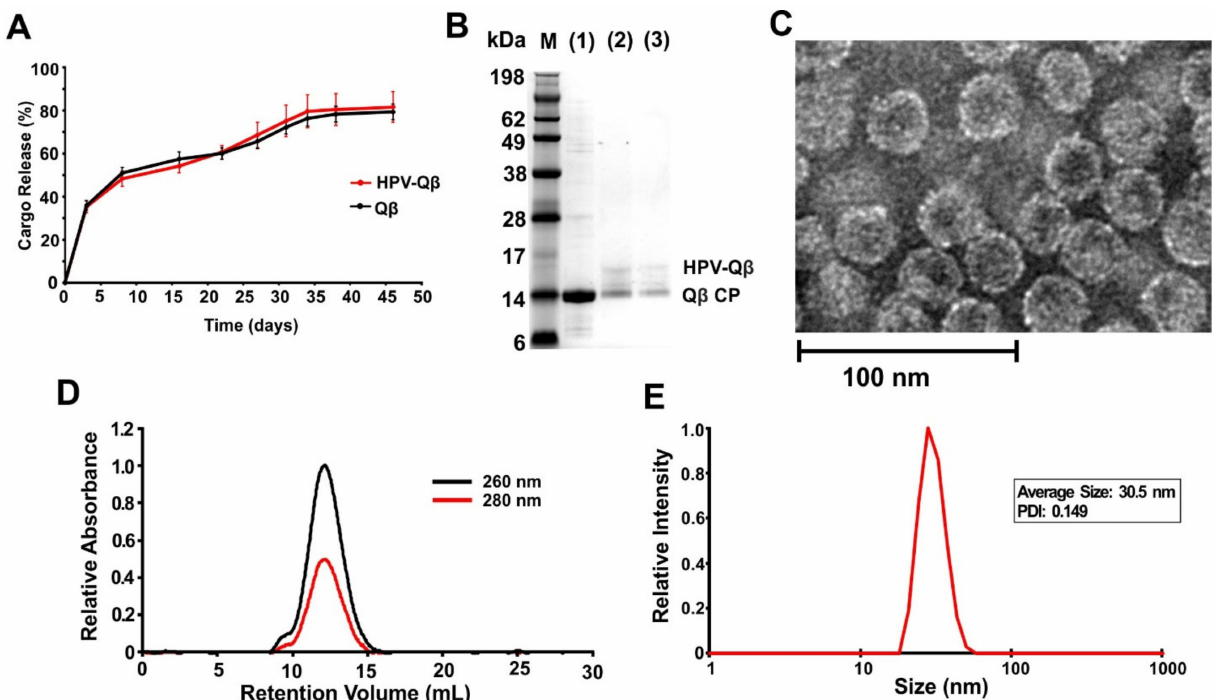
Figure 3. Slow release of Q β -HPV from the PLGA implant. ( A ) The release curve of the PLGA implants loaded with Q β -HPV or Q β , with the particles released into PBS at 37 ◦ C (data are means ± standard deviations, n = 3). ( B ) SDS-PAGE analysis of (1) unmodified Q β standard and Q β -HPV released from the implant between (2) 0–15 days and (3) 16–30 days. ( C ) TEM image of the released Q β -HPV particles on day 30. ( D ) FPLC analysis of the released Q β -HPV particles on day 30. ( E ) DLS analysis of the released Q β -HPV particles on day